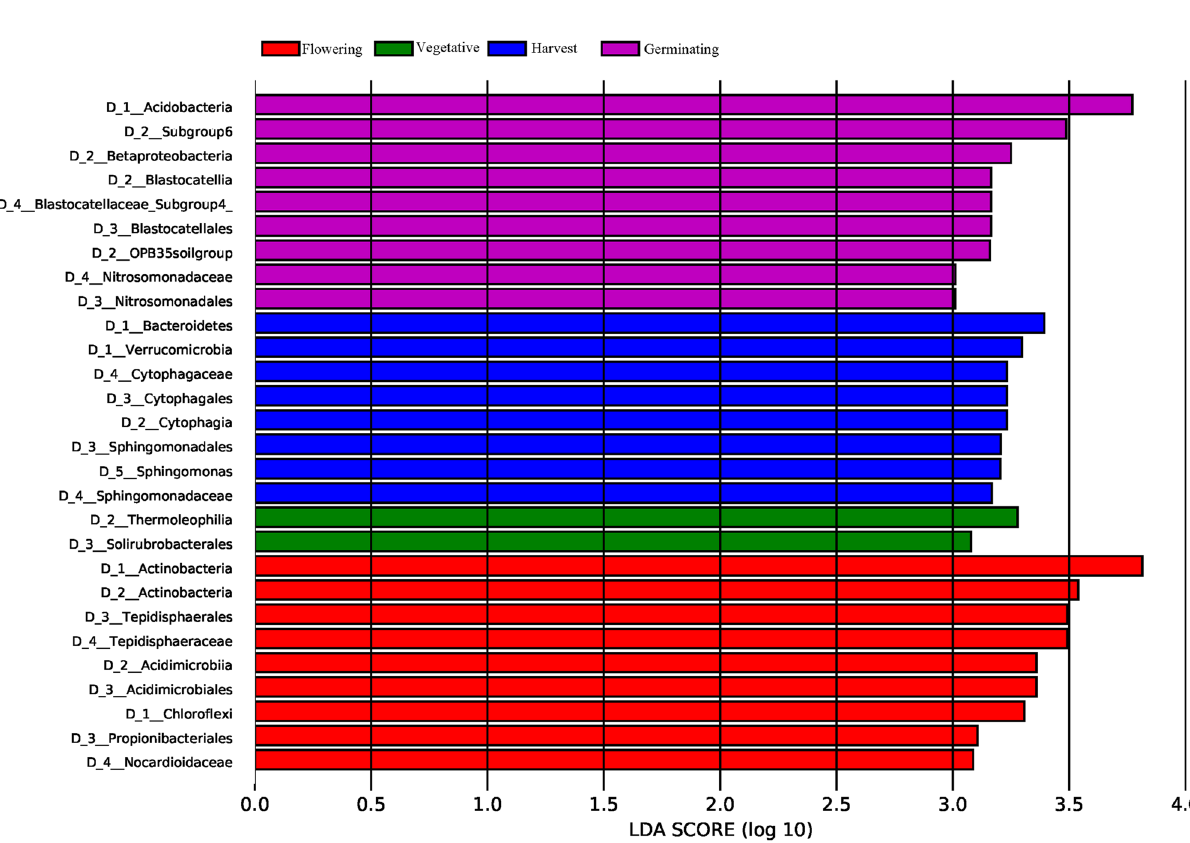
LDA threshold of > 3 are